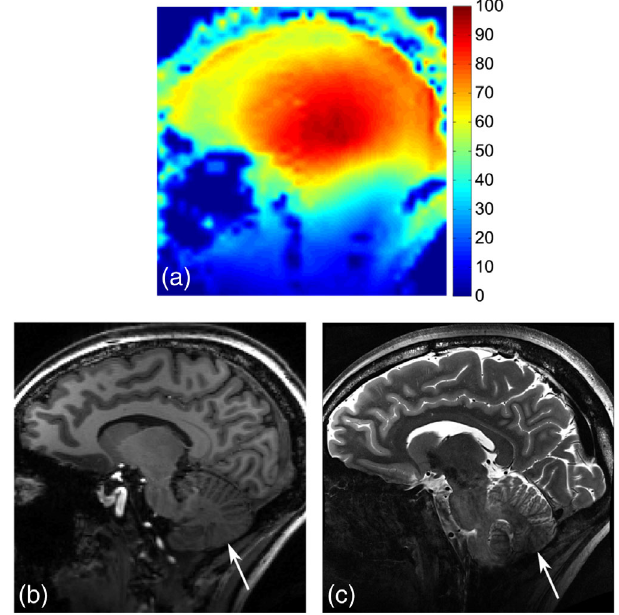
FIG. 1. 7 T sagittal MR images of a human brain slice obtained with various acquisition sequences: (a) Flip-angle (FA ∝ B þ 1 ) map acquired using the actual flip-angle imaging sequence (color bar in degree). (b) T1-weighted magnetization-prepared rapid gradient echo sequence. (c) T2-weighted turbo spin echo sequence. Those images have been acquired with a birdcage coil for excitation and a 32-loops phased array for reception. Notice (a) the large B þ 1 field heterogeneity over the head (dispersion of ∼ 30% ). When FA is too far from the target, as is the case here in the cerebellum (white arrows), it leads to loss in contrast (b) or even worse to shadowing (c) depending on the acquisition